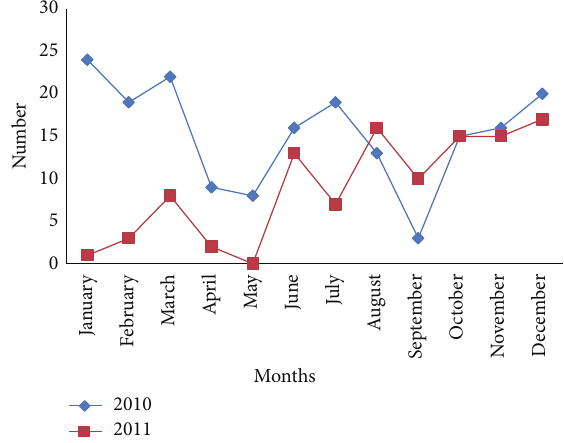
Figure 2: The monthly distribution of Linguatulosis in dogs in Jalingo, North Eastern Nigeria, for the years 2010 and